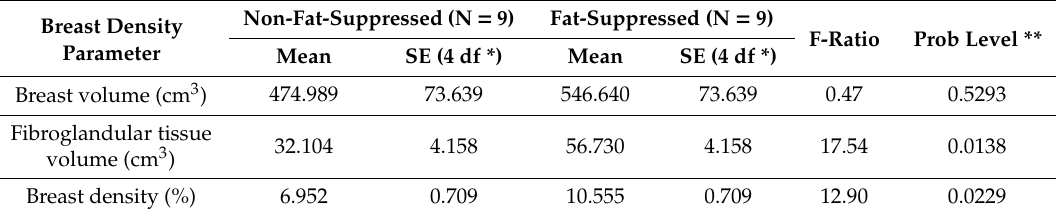
Table 3. Results of the repeated-measures ANOVA, including total mean, standard error (SE), F-ratio, probability level (Prob level) of breast volume, fibroglandular tissue volume, and percentage of breast density between two imaging groups: non-fat-suppressed and fat-suppressed MRI pulse sequences. Breast